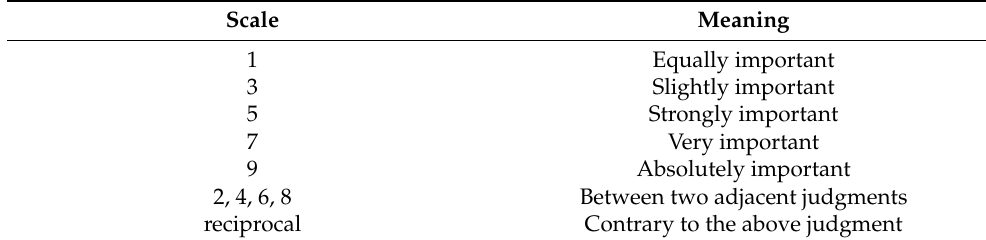
Table 1. Meaning of the relative importance scale.